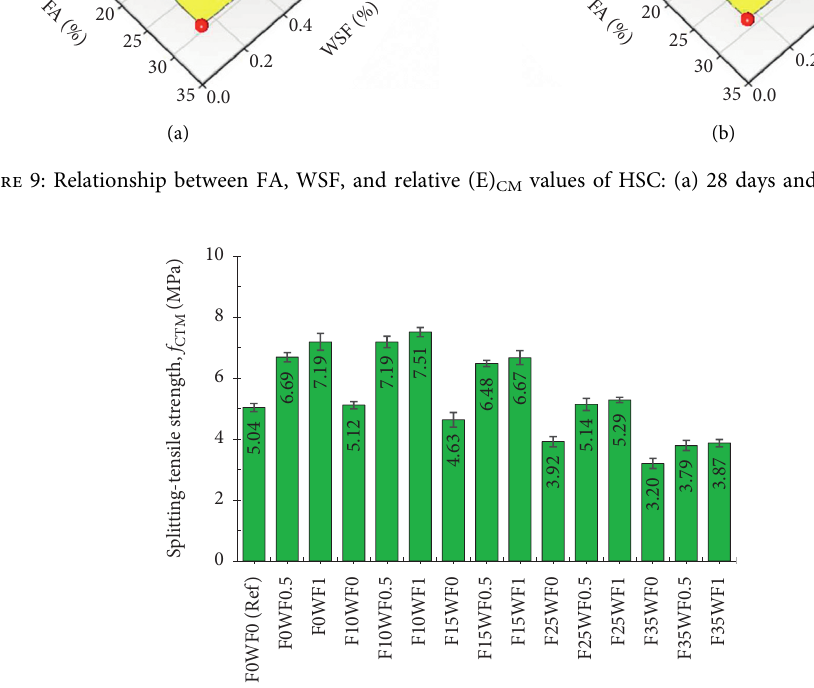
Figure 10: The f CTM value of HSC with different incorporation levels of FA and